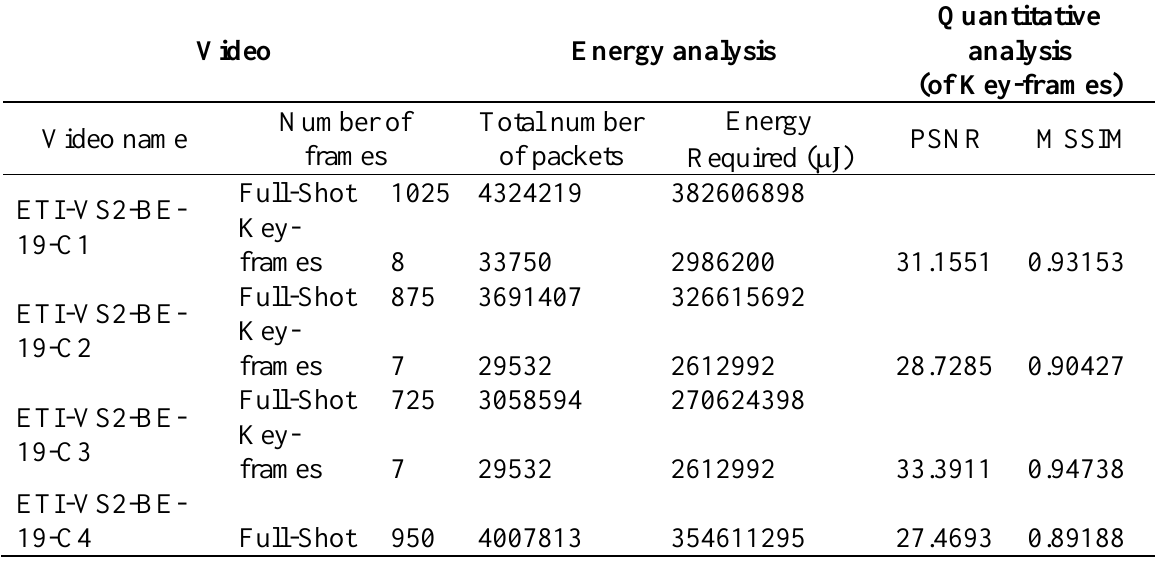
Table 7. Transmission energy and Quantitative analysis for four videos of the same